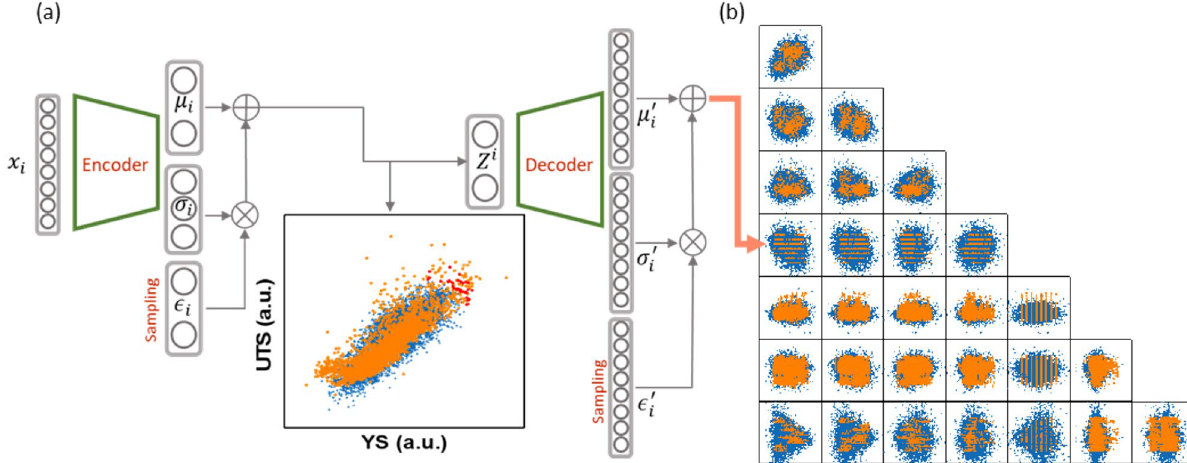
Figure 8. ( a ) The MVAE architecture exhibiting both the encoder and decoder and the distribution of Z data (blue crosses) sampled from the latent vector, along with the real YS-UTS data plot (amber dots), and the red dots in the Z distribution that designate the top four Pareto frontiers to be selected as a decoder input batch for (cid:31) X an inverse prediction; ( b ) the MVAE-generated data distribution sampled from the decoder output layer (blue (cid:31) X crosses) and the input X data (amber dots); the multivariate and X data are schematically represented as 2-D data distributions for all possible binary feature e